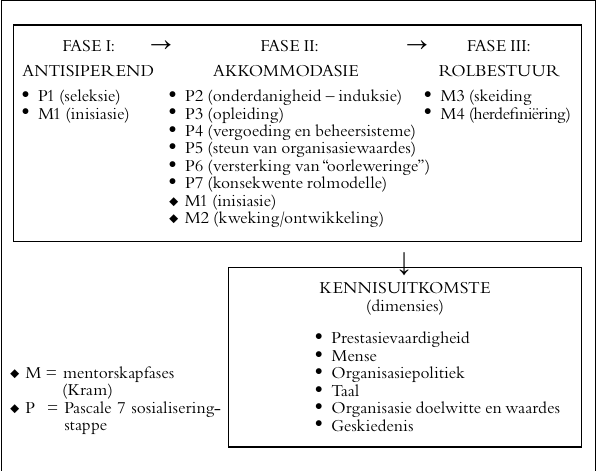
Figuur1:Sosialiseringsproses Uit die literatuur blyk dit dat daar geen empiriese resultate bestaan watduiop’nverbandtussenorganisasiesosialiseringenorganisasie- verbondenheid nie. Die navorsingsvraag is: ‘‘Bestaan daar ’n ver- band tussen organisasiesosialisering en -verbondenheid?’’ In die lig van die voorgaande bespreking is dit die doel van die studie omte bepaalofdaar’nverband bestaantussenorganisasieso- sialisering (wat mentorskap insluit) en organisasieverbondenheid.